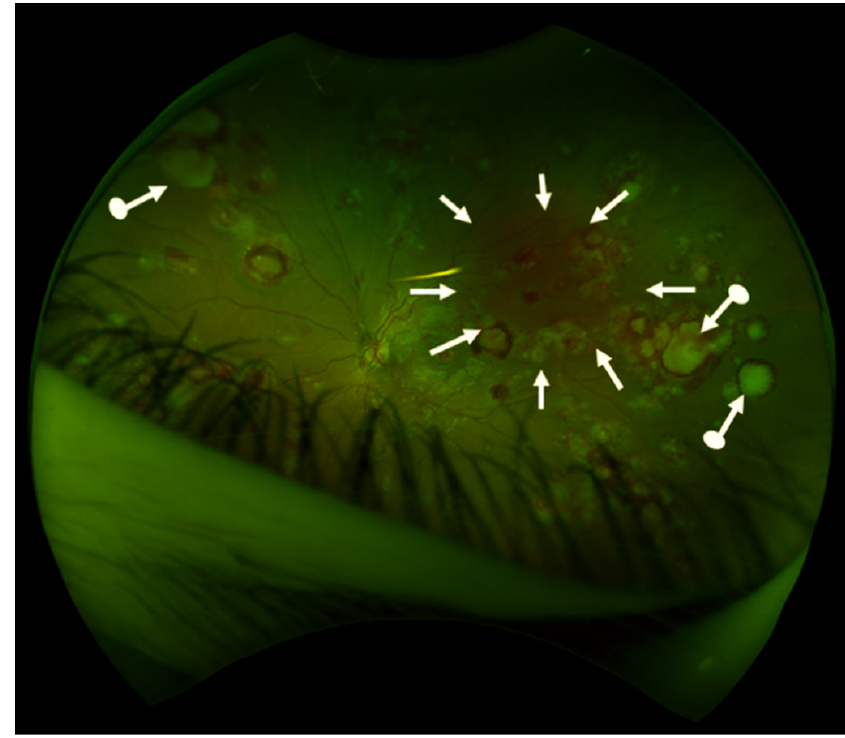
Figure 4. Retinal findings in a 15-year old girl who presented with blurred vision, massive splenomegaly and leukocytosis. A diagnosis of CML-AP was made. Retina is the most commonly involved intraocular structure in CML. Fundus showed retinal hemorrhages in both eyes (white arrows) and multiple white centered infiltrates “cotton-wool spots” (arrows with dot, not all infiltrates are marked). Photography (OPTOS retinal camera) by courtesy of F. Gekeler, Stuttgart). Splenomegaly is observed in two thirds of all pediatric patients. Imaging procedures show no grossly visible nodules; however, splenic infarcts may appear if the organ is massively enlarged (Figure 5). Rarely, cases with splenic rupture have been reported in adults, but so far, not in children